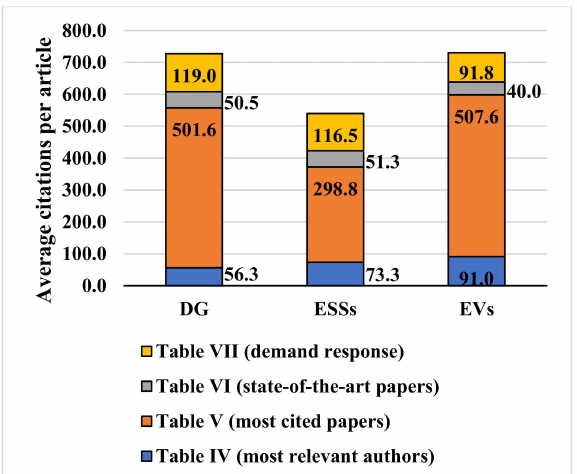
Figure 11. Comparison among the emphasis on distributed generation, energy storage systems, and electric vehicles in terms of average citations per article. Source: own study using data from